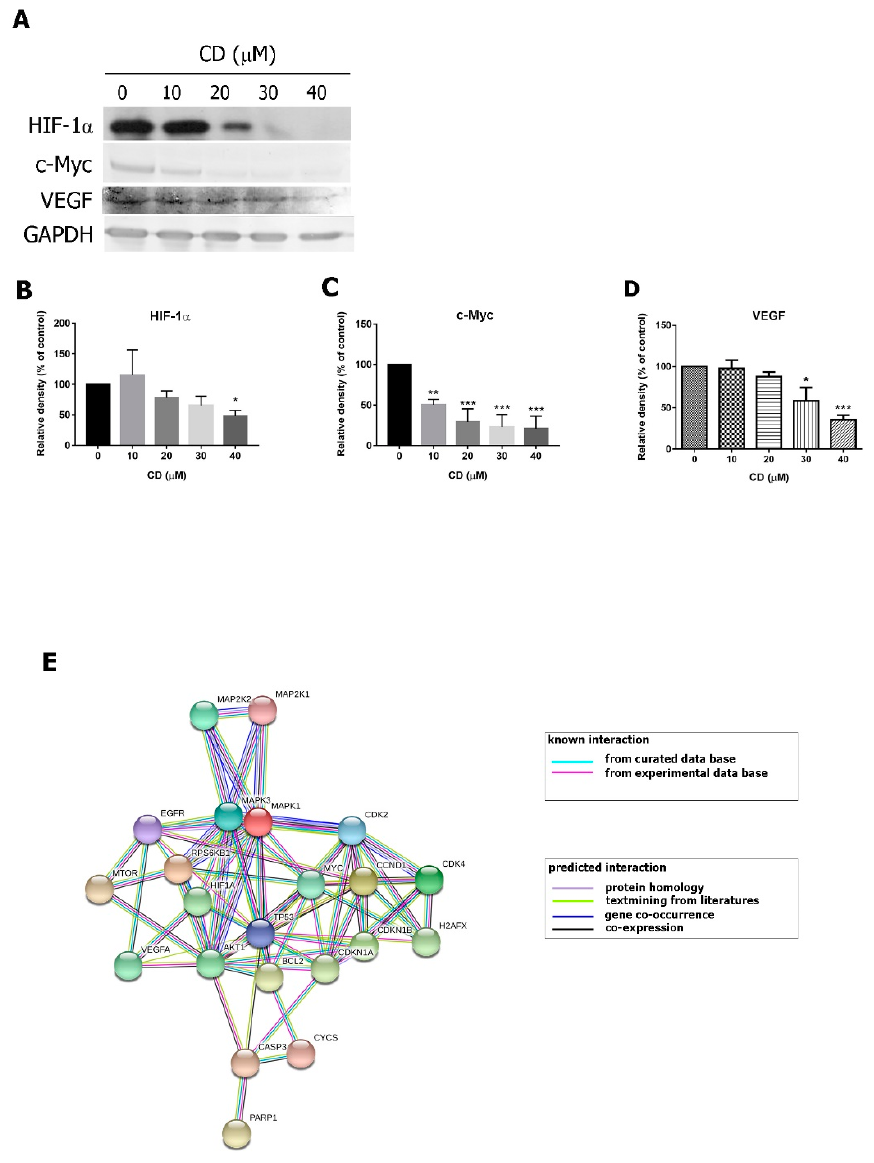
Figure 8. The effects of CD on c-Myc, HIF-1 α , and VEGF proteins. ( A ) The protein expressions of c-Myc, HIF-1 α and VEGF. GAPDH was used as an internal control. ( B – D ) Quantification results of each protein. Bar graphs show normalized values as percentages relative to the control. Data are expressed as mean ± SD of three to four independent experiments. * p < 0.05, ** p < 0.01, *** p < 0.001 as compared to the control group (0 µ M). ( E ) The protein interaction map.